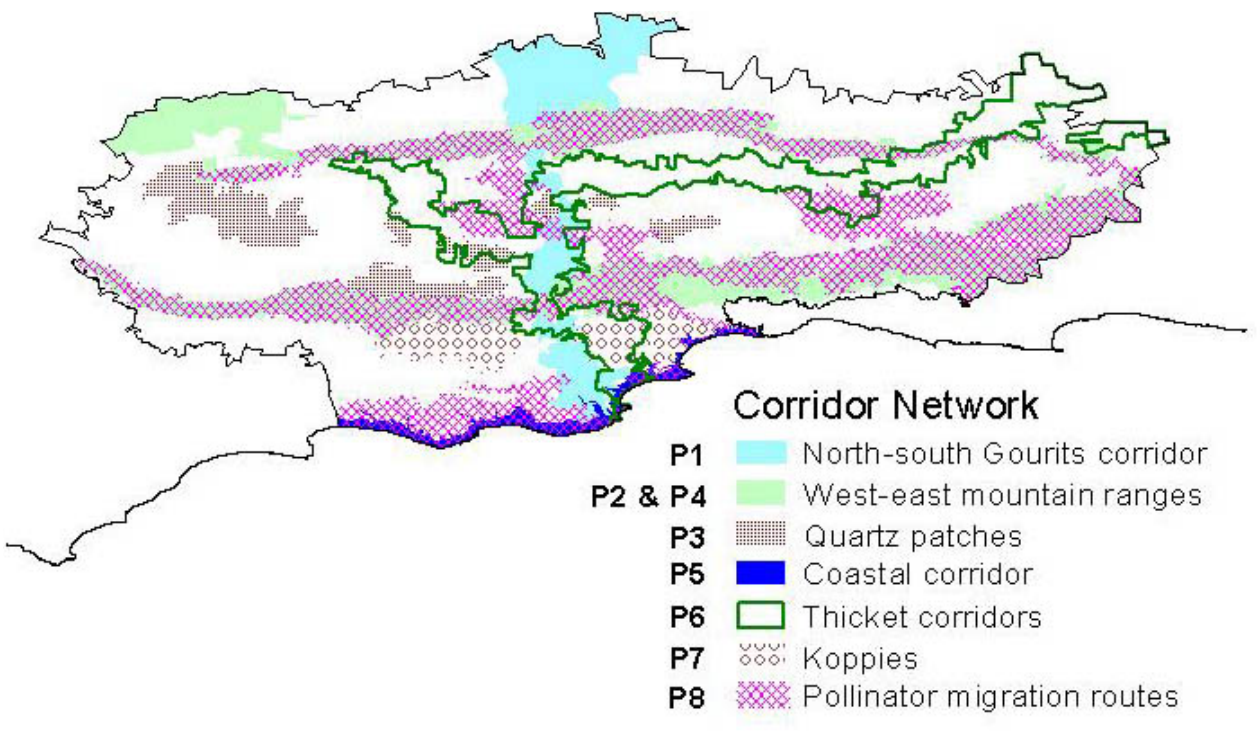
Fig. 4. The corridor network developed for the Gouritz planning domain. Corridors are defined by nine broad-scale biodiversity processes (P1-9), matched to the closest planning unit boundary. Note that P9, i.e., lowland vegetation and finer-scale processes, occurs at scales finer than can be plotted in this